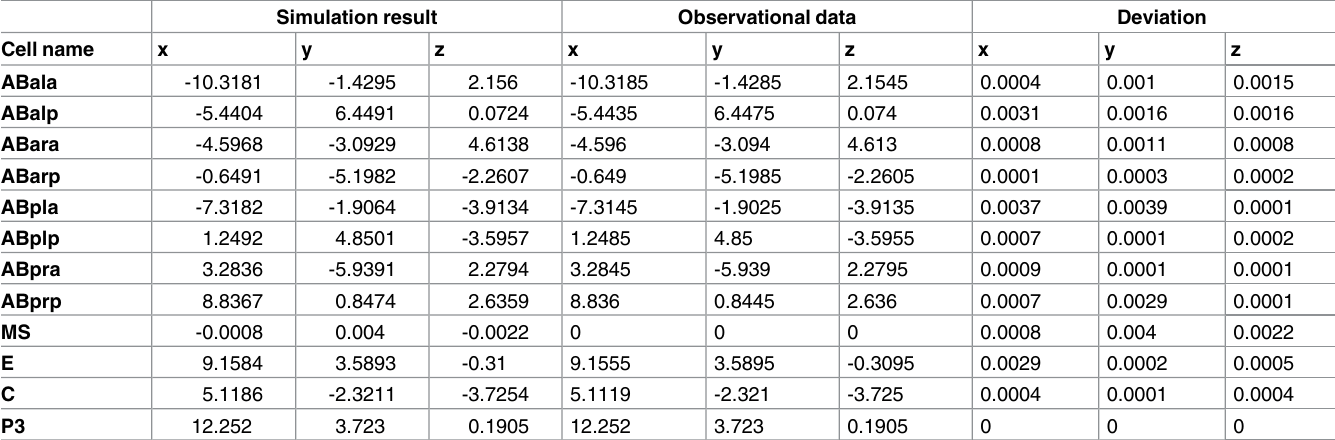
Table 7. Analysis of dividing positions of 12 founder